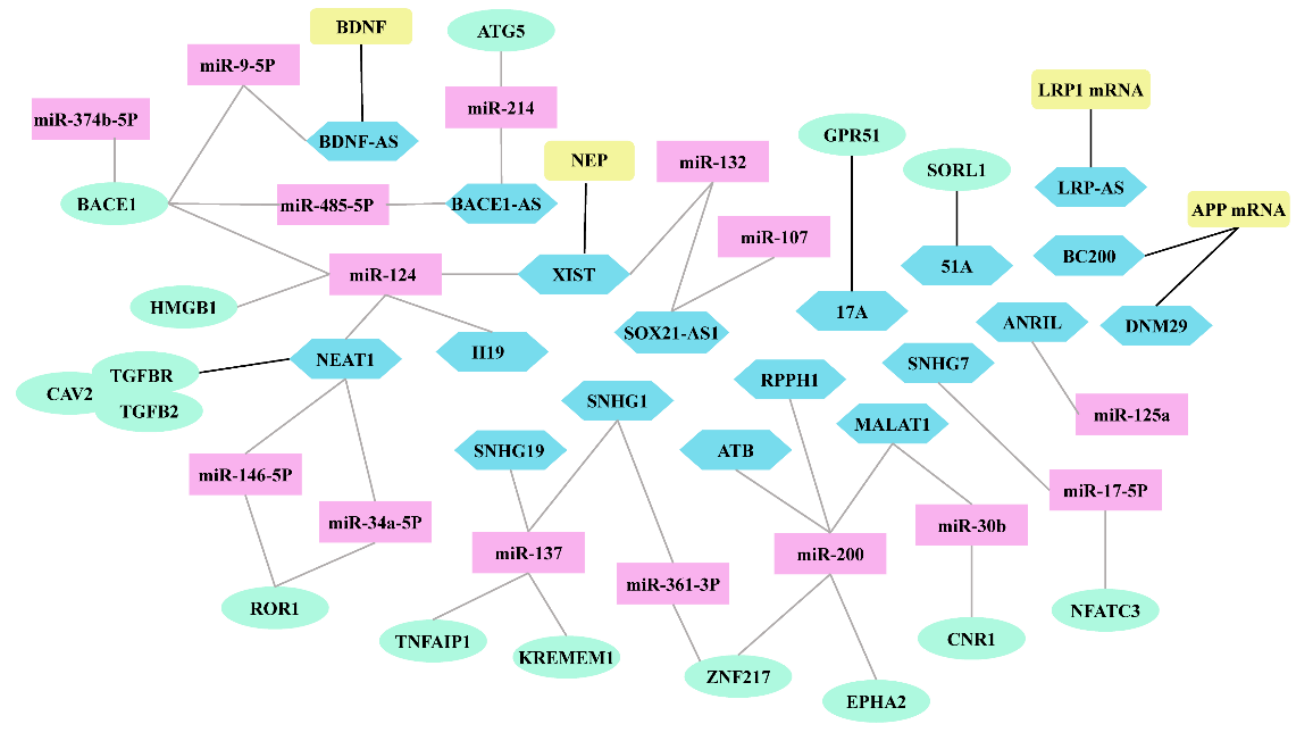
Figure 3. Complexity and interactions of lncRNAs in Aβ cascade hypothesis. Gray lines represent the ceRNA axis of lncRNAs. Black lines represent other mechanisms of action of lncRNAs, including mRNA transcription (NDM29, BC200, and LRP-AS), mRNA splicing (51A and 17A), and histone modification (NEAT1, XIST, and BDNF-AS).